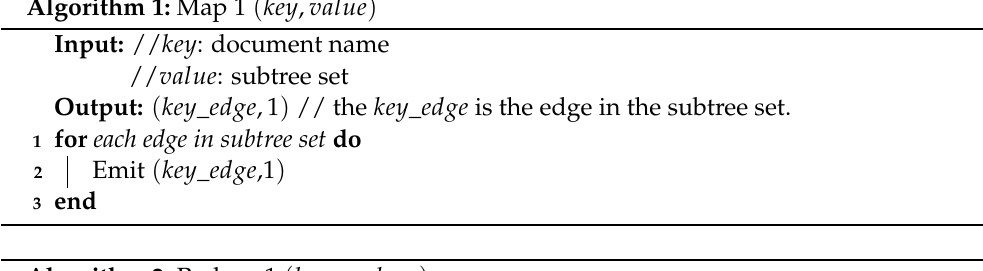
Algorithm 2: Reduce 1 ( keys , values